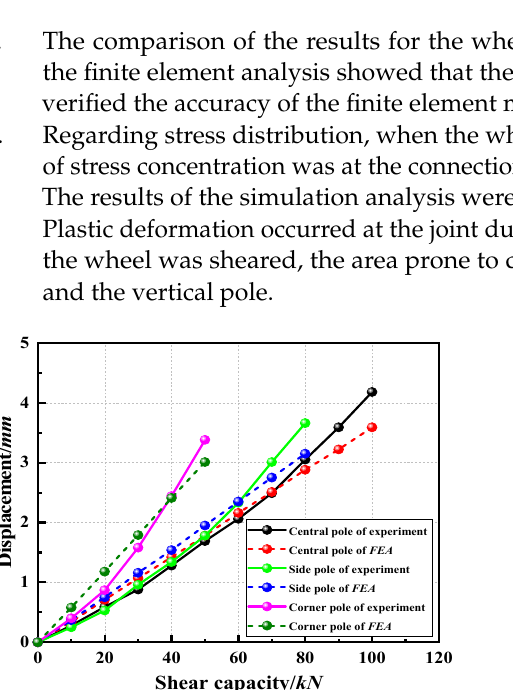
Figure 14. Finite element analysis of wheel shear: ( a ) 𝐹𝐸𝐴; ( b ) central pole; ( c ) side pole; ( d ) corner pole.